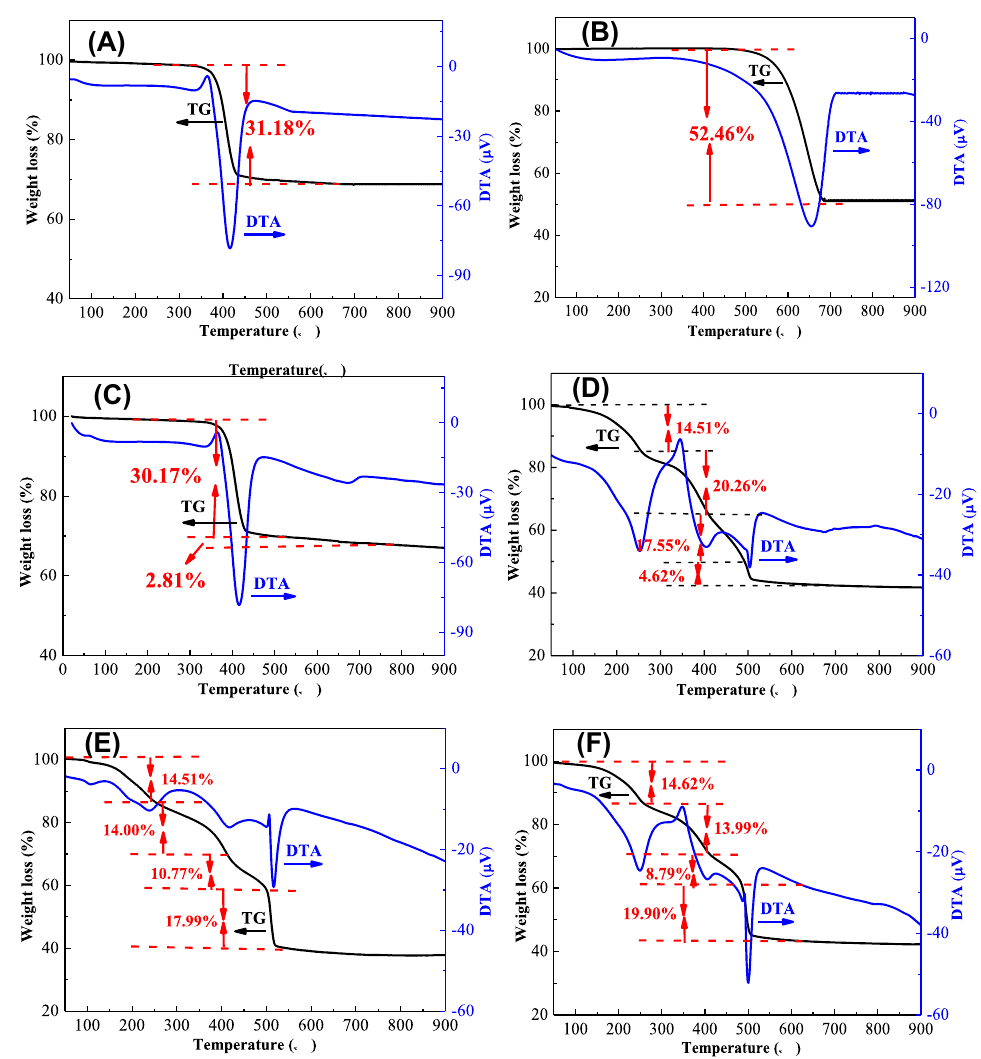
Figure 5. ( A – F ) TG–DTA curves of the dried precursors prepared by different types and concentrations of precipitants: ( A ) MgO-P-NaOH-3-Pre, ( B ) pure MgCO 3 , ( C ) MgO-P-NaOH + Na 2 CO 3 -3/1-Pre, ( D ) MgO-P- NaOH + Na 2 CO 3 -1/3-Pre, ( E ) MgO-P-Na 2 CO 3 -3-Pre, ( F ) MgO-P-Na 2 CO 3